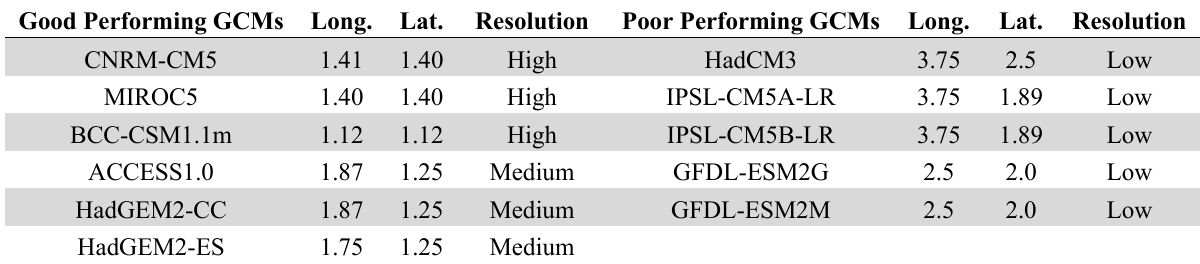
Table 2. Ranking of CMIP5 GCMs based on simulation of precipitation over Lake Victoria. Good Performing GCMs Long. Lat. Resolution Poor Performing GCMs Long. Lat. Resolution CNRM-CM5 1.41 1.40 High HadCM3 3.75 2.5 Low